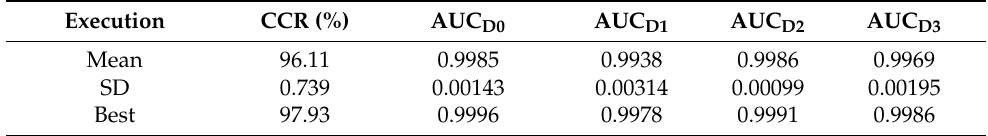
Table 8. Performance of the ANN-ICA classifier for early detection of excess nitrogen using spectral data, comparing the mean and standard deviation (SD) of the 200 repetitions, and the best